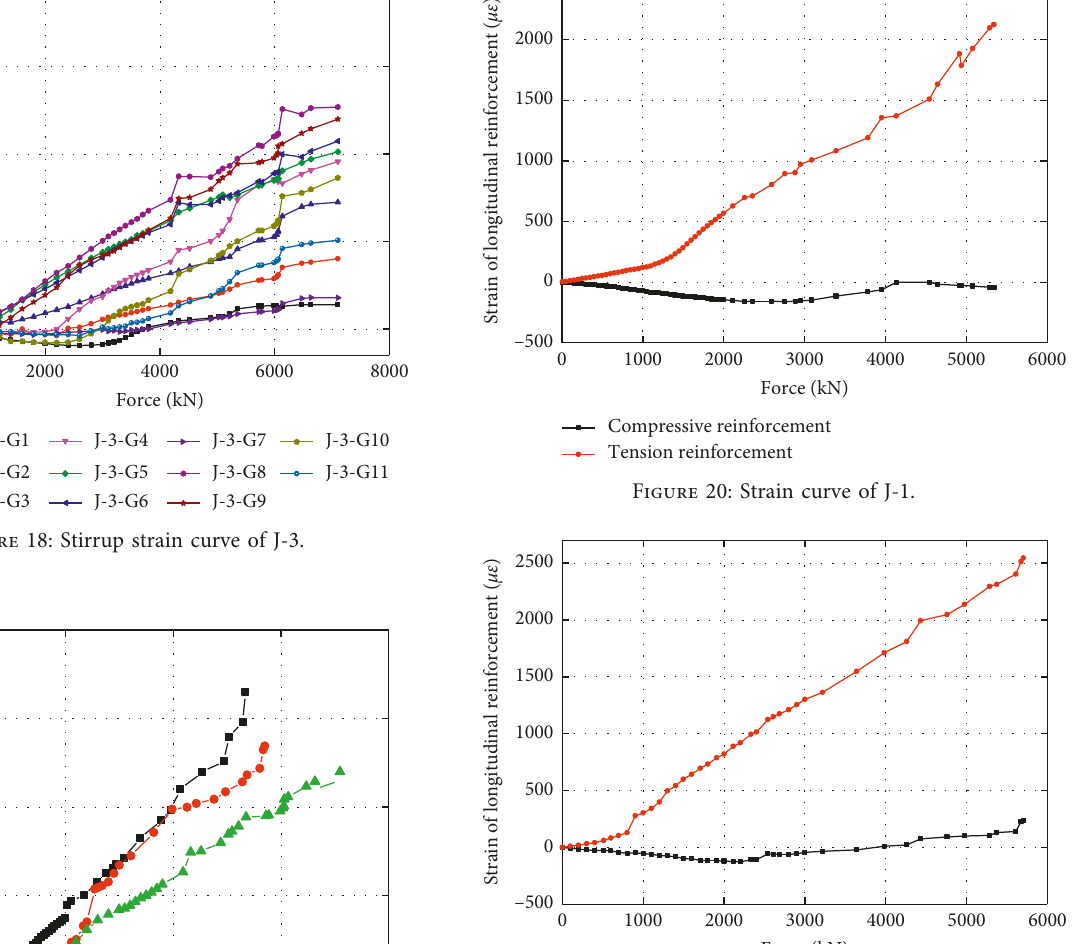
Figure 21: Strain curve of